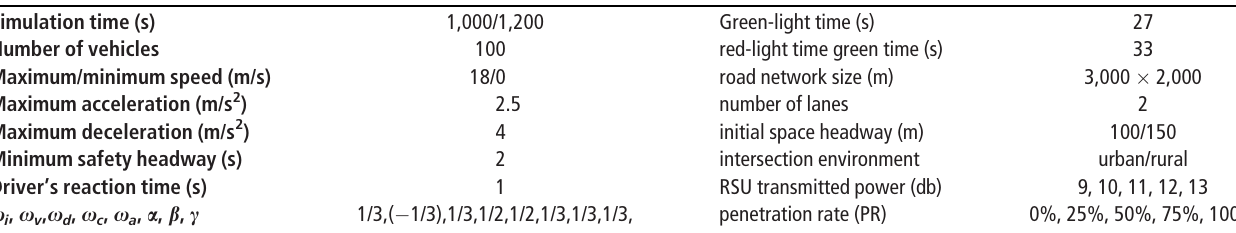
Table 3 Simulation experiment parameters and simulation scenarios